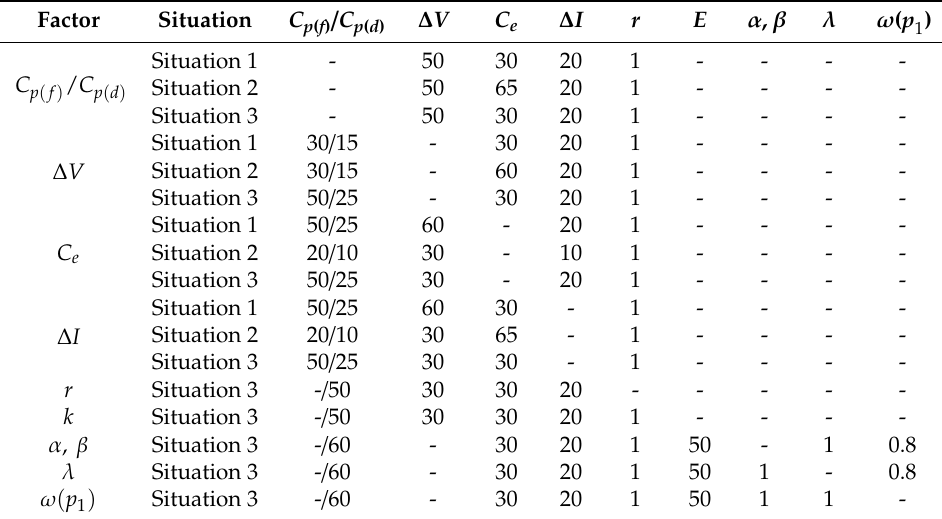
Table 7. Values of each factor in the proposed models in Situations 1, 2, and